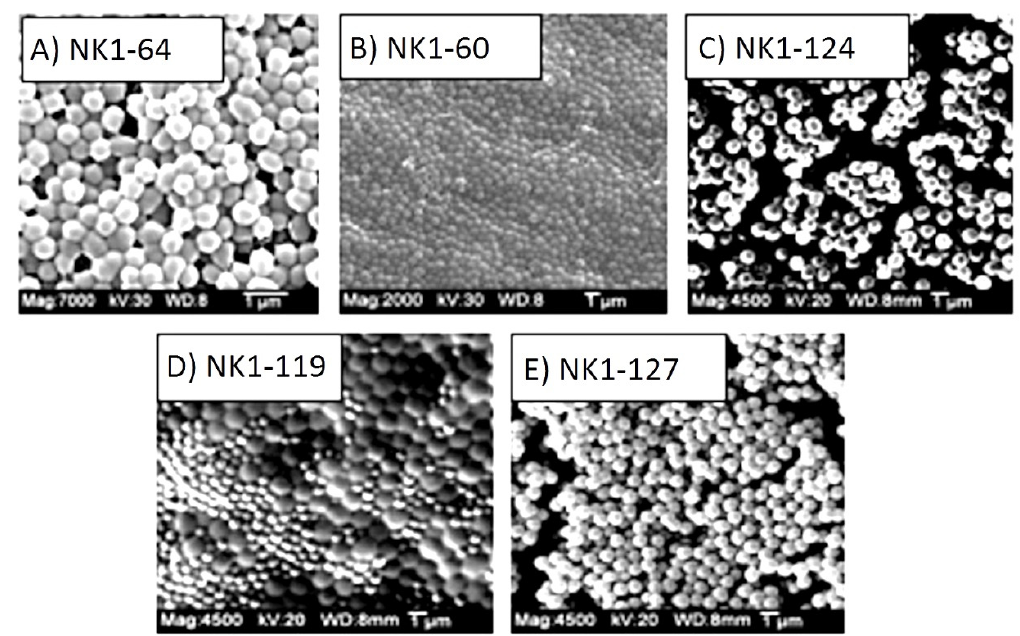
Figure 1. SEM snapshots of NIPA copolymers prepared by dispersion polymerization: ( A ) NK 1-64 (5% MAA), ( B ) NK 1-60 (10% MAA), ( C ) NK 1-124 (15% MAA), ( D ) NK 1-119 (20% MAA), ( E ) NK 1-127 (25% MAA) .